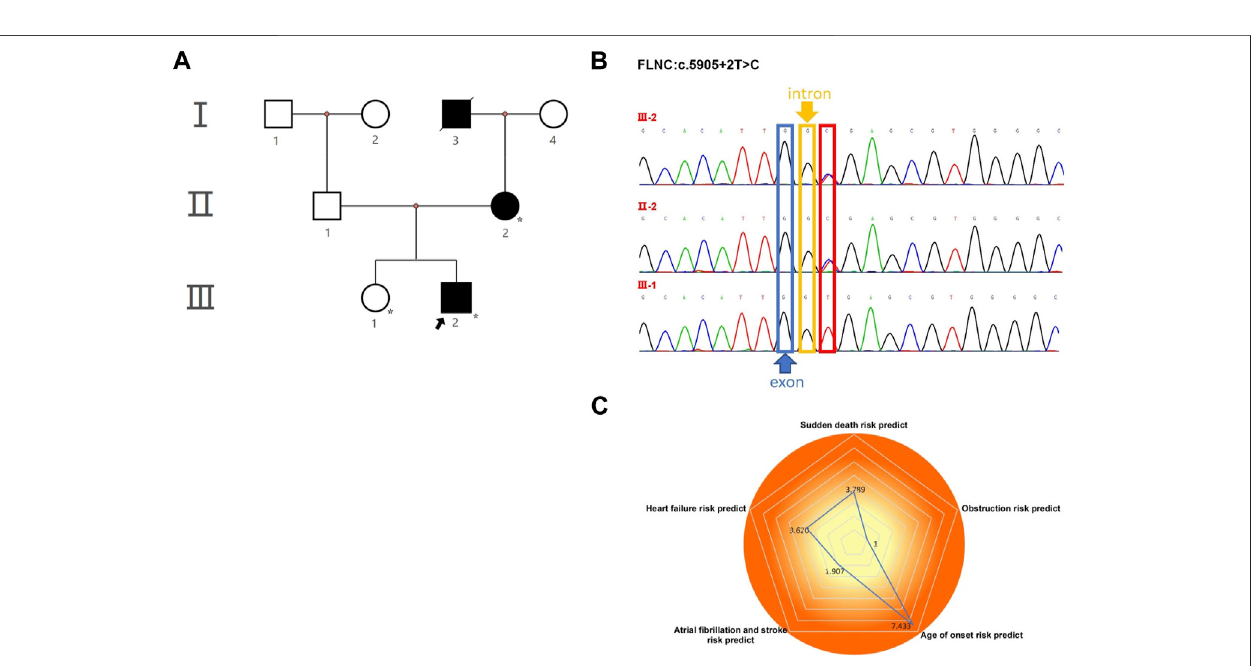
FIGURE 1 | Pedigree analysis and sequencing results. (A) Pedigree of the proband (arrow) and his family members with heterozygous FLNC mutations. The star symbol indicates the used WES. (B) Sanger sequencing con fi rmed a splicing mutation in FLNC , which was of maternal origin. It is highlighted in the red box. (C) Assessment of fi ve prognostic risk factors for